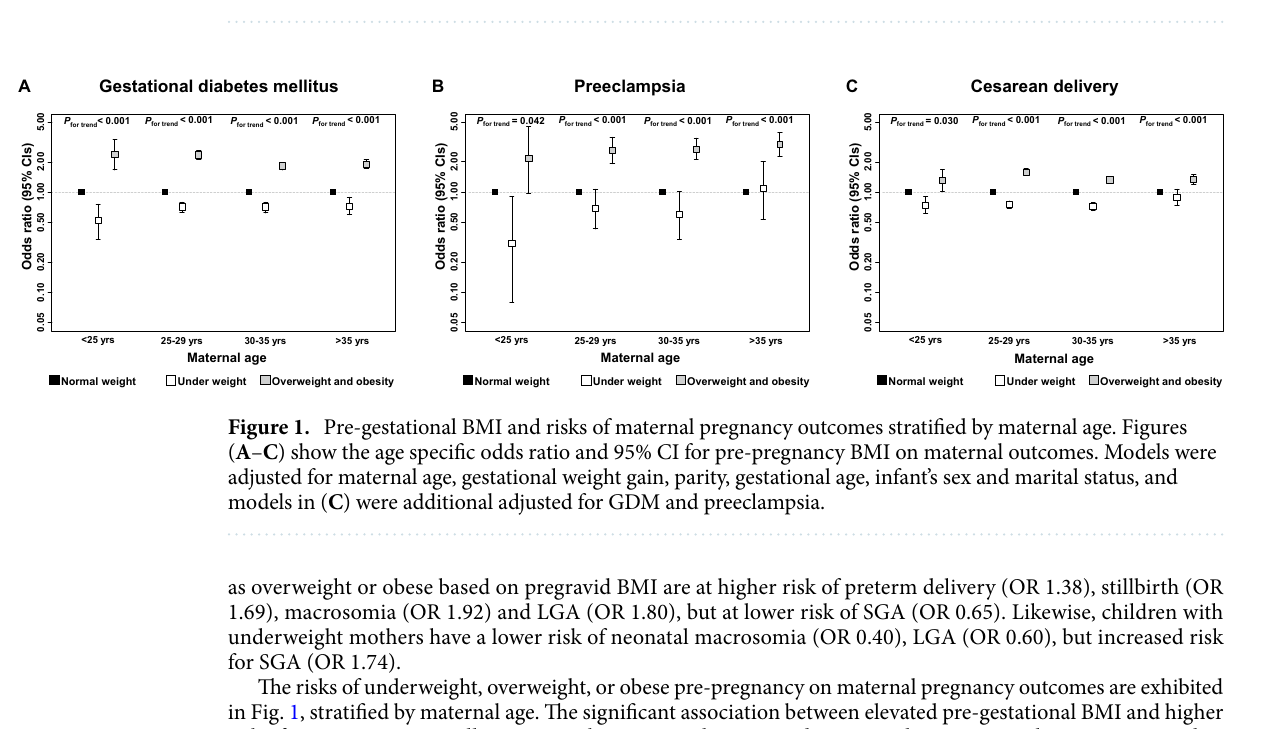
as overweight or obese based on pregravid BMI are at higher risk of preterm delivery (OR 1.38), stillbirth (OR 1.69), macrosomia (OR 1.92) and LGA (OR 1.80), but at lower risk of SGA (OR 0.65). Likewise, children with underweight mothers have a lower risk of neonatal macrosomia (OR 0.40), LGA (OR 0.60), but increased risk for SGA (OR 1.74). The risks of underweight, overweight, or obese pre-pregnancy on maternal pregnancy outcomes are exhibited in Fig. 1, stratified by maternal age. The significant association between elevated pre-gestational BMI and higher risk of GDM exist across all age ranges, but was much more evident in mothers younger than 30 years. Within the higher age categories, there is an increasing trend in the risk of pre-pregnancy overweight or obesity on preeclampsia. The protective effect of underweight, however, was merely significant in mothers of the youngest age category. Despite the age categories, pregravid overweight or obesity are risk factors for conducting a cesarean